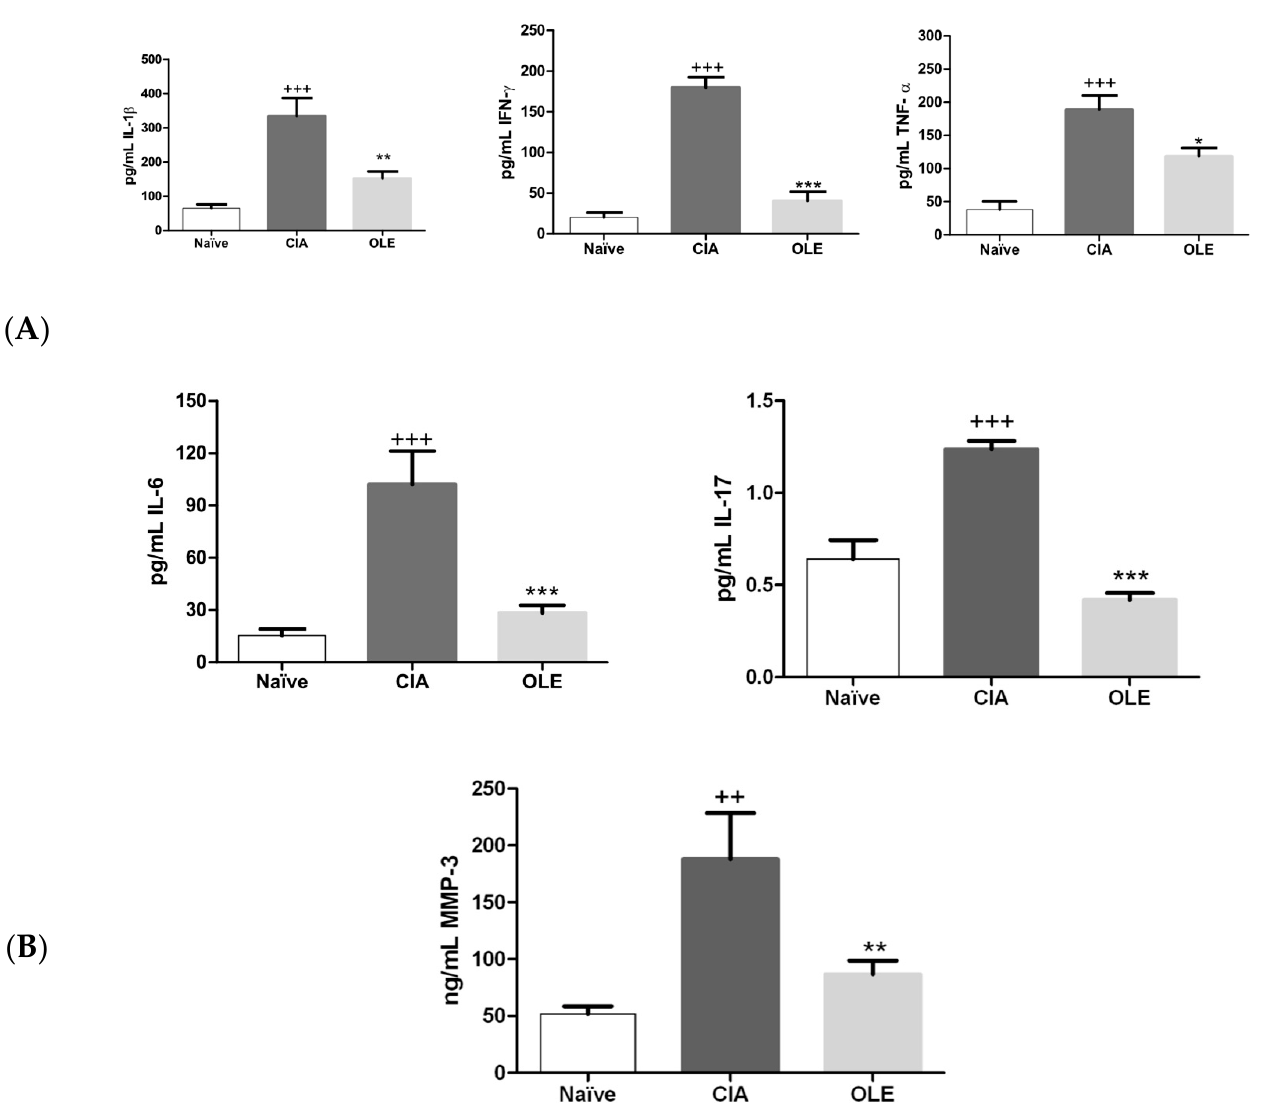
Figure 3. Effects of dietary oleocanthal on MMP-3 and joint inflammatory biomarkers levels. ( A ) OLE diet down-regulated the levels of pro-inflammatory cytokines: IL-1 β , IFN- γ , IL-6, IL-17 and TNF- α in tissue homogenates; ( B ) MMP-3 levels was decreased in serum of animals fed with OLE diet. Naïve group, non-arthritic control animals fed with SD; CIA, control group induced arthritic animals fed with SD; OLE induced arthritic animals fed with OLE enriched diet (0.025% w/w ). Values are represented as mean ± S.E.M. ( n = 8), ++ p < 0.01; +++ p < 0.001 vs. Naïve group; * p < 0.05; ** p < 0.01; *** p < 0.001 vs. CIA group.